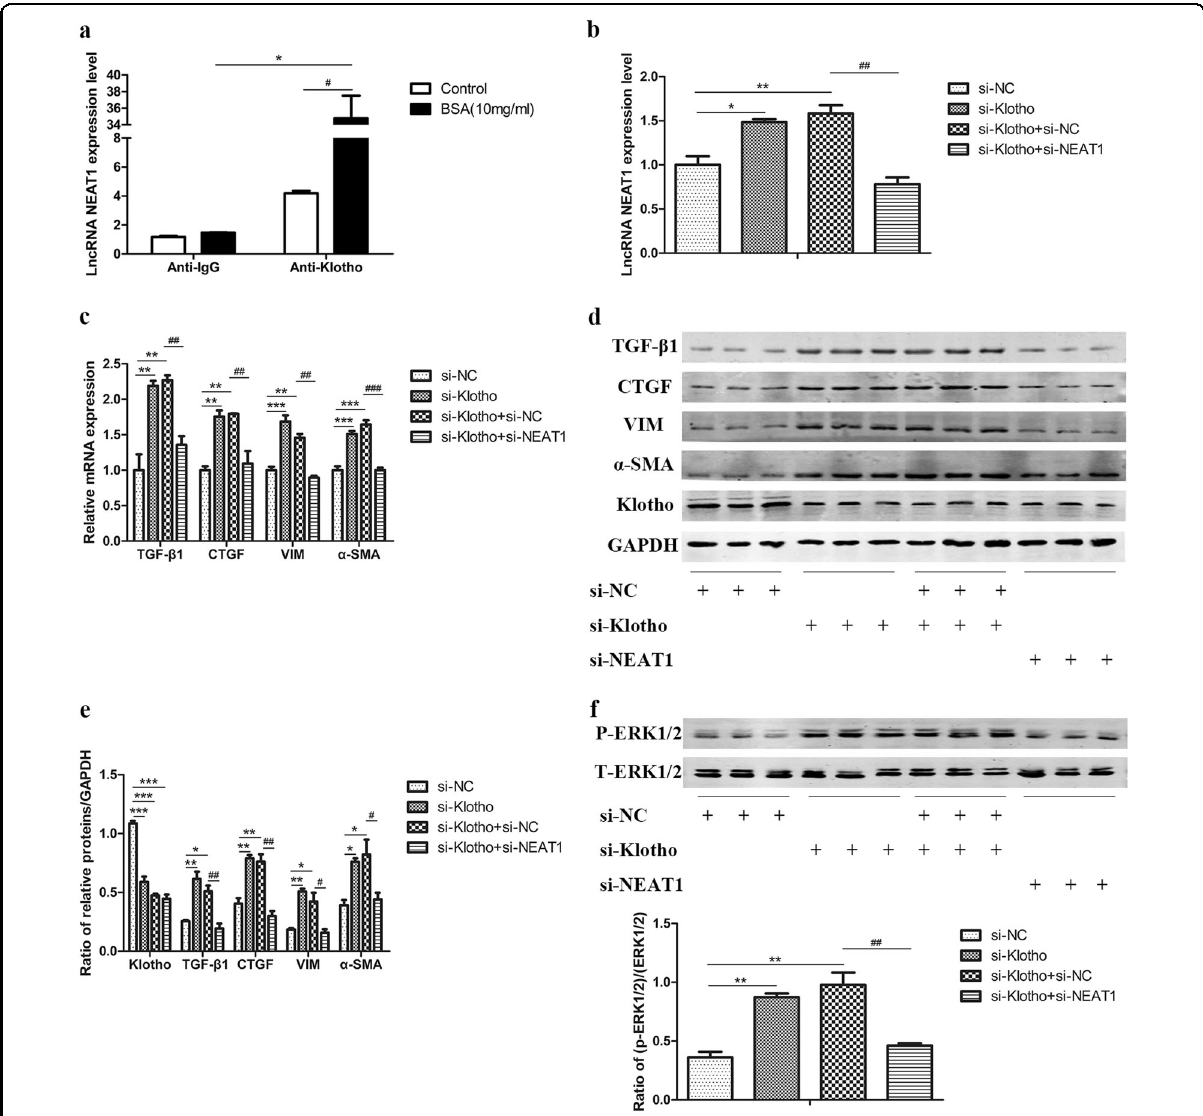
Fig. 8 NEAT1 is involved in the protective effect of Klotho. RNA immunoprecipitation was performed using an anti-Klotho antibody or anti-IgG antibody as a control in BSA-treated HK-2 cells for 48 h. a lncRNA NEAT1 expression was measured by qRT-PCR. # p < 0.05 vs control, ## p < 0.01 vs control, ### p < 0.001 vs control. HK-2 cells were cotransfected with si-Klotho and si-NEAT1. b , c lncRNA NEAT1 expression and the mRNA levels of TGF- β 1, CTGF, vimentin, and α -SMA were measured by qRT-PCR. d , e The protein levels of TGF- β 1, CTGF, vimentin, α -SMA, and Klotho were measured by western blots. f Expression of total and phosphorylated ERK1/2 protein was detected by western blots. * p < 0.05 vs si-NC, ** p < 0.01 vs si-NC, *** p < 0.001 vs si-NC; # p < 0.05 vs si-Klotho + si-NC, ## p < 0.01 vs si-Klotho + si-NC, ### p < 0.001 vs si-Klotho +